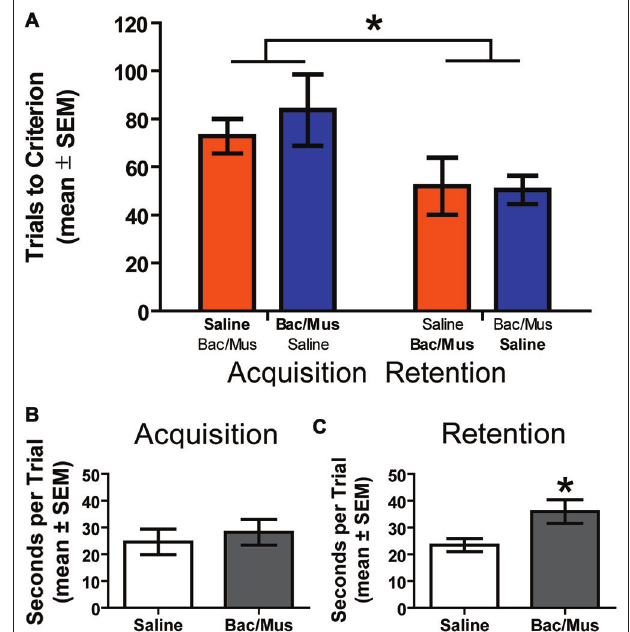
FIGURE 11 | Results of LHb inactivation on the acquisition and retention of an initial probabilistic discrimination. (A) Results of a two way ANOVA revealed that treatment order did not affect the number of trials to criterion on either acquisition or retention of the probabilistic place/response discrimination. However, rats required fewer trials to reach criterion on retention than on acquisition. (B) No effect on the seconds per trial was observed on acquisition following LHb inactivation. (C) However, inactivation of the LHb during retention significantly increased the seconds per trial. ∗ p <